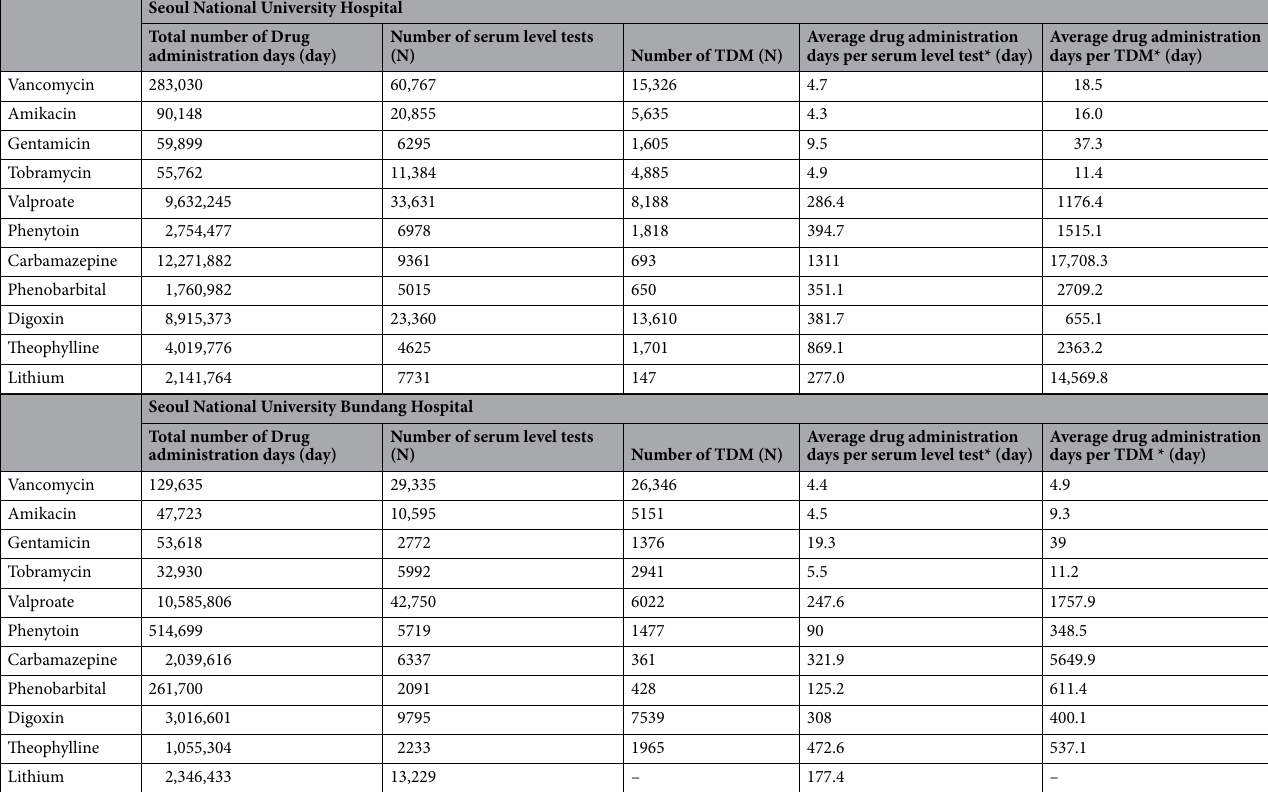
Table 2. Total number of drug administration days, number of serum level tests and therapeutic drug monitoring, and average administration days per serum level test or therapeutic drug monitoring. *The ratio was rounded to the first decimal